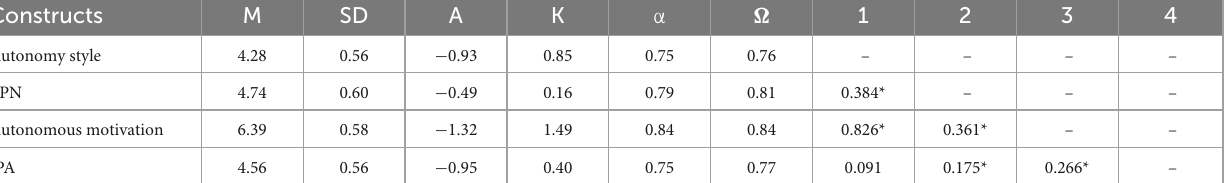
TABLE 1 Mean, standard deviation, reliability, and bivariate correlations of the study variables.